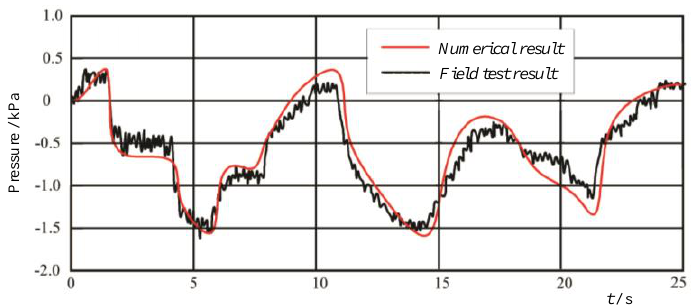
Figure 13. Comparison of the time history of pressure on the train surface between the field test and the present numerical simulation (train speed = 200 km/h; wind velocity = 0 m/s).